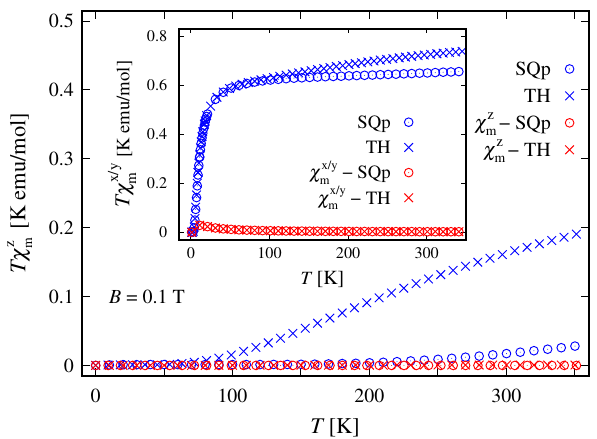
Figure 8. Low-field molar susceptibility as a function of the temperature in the case of a square planar (SQp) and tetrahedral (TH) geometries. The data are extracted for parameters given at the end of Section 2.1 and the ratio between the corresponding molar mass and density is taken as unity. In the inset, the superscript x / y stands for both the x and y components.